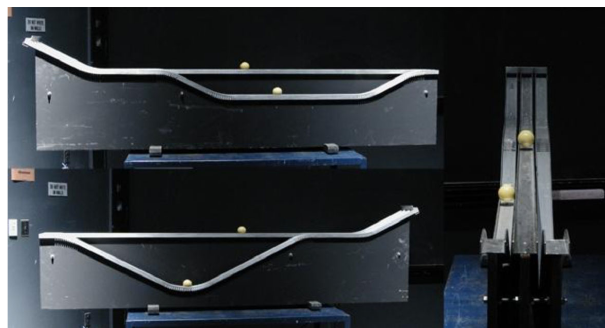
FIG. 6. Images of two different High Road, Low Road